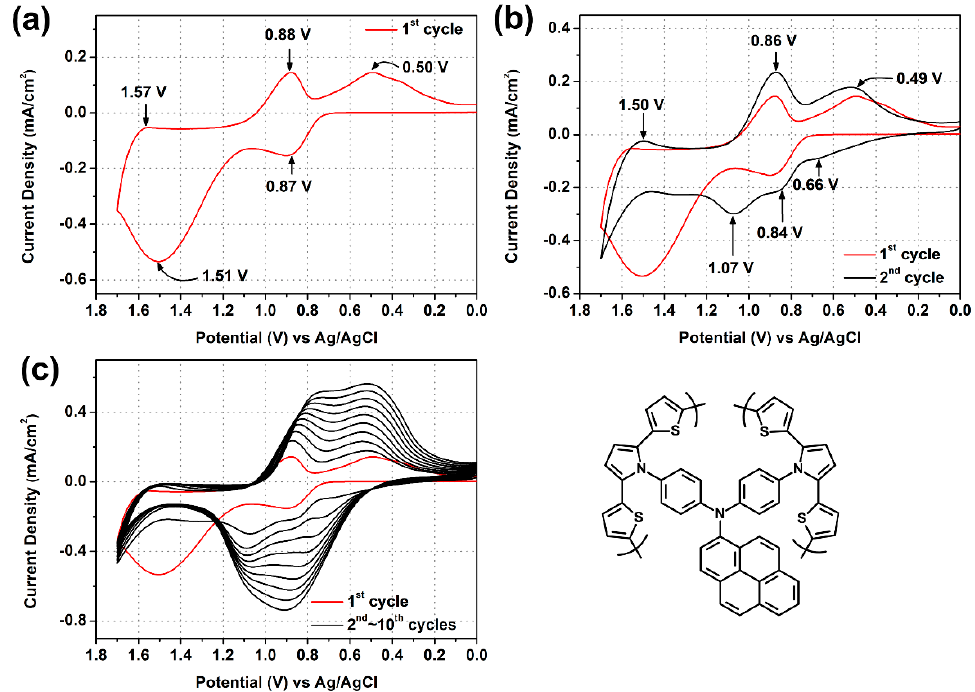
Figure 3. ( a ) The first CV scan, ( b ) the first two second CV scan, and ( c ) ten repetitive CV scans of 0.2 0.2 mM of DPPA-2SNS in 0.1 M Bu 4 NClO 4 / CH 2 Cl 2 in the potential range of 0.00–1.70 V at a scan rate mM of DPPA-2SNS in 0.1 M Bu 4 NClO 4 /CH 2 Cl 2 in the potential range of 0.00–1.70 V at a scan rate of of 50 mV / s. 50 mV/s.